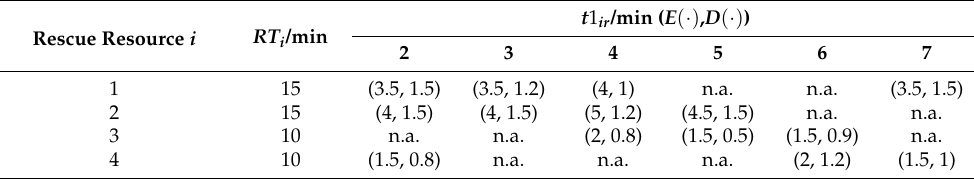
Table 5. The maximum tolerable transport time and the assembly time of each rescue center.